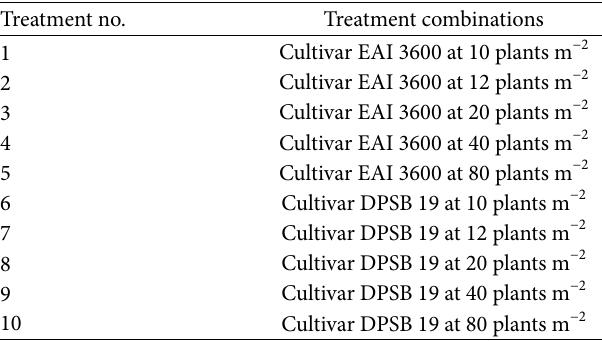
Table 1: Description of treatments for soybean density experiment, Egerton, Kenya during 2018 season. Treatment